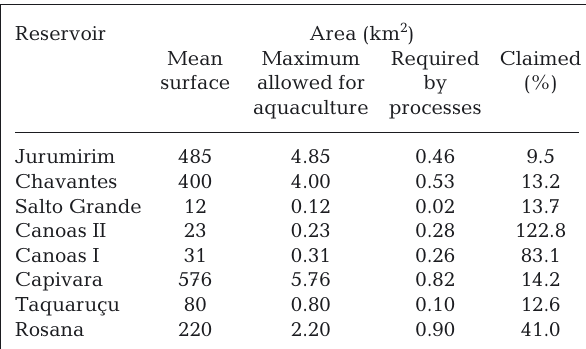
Table 4. Areas requested for the establishment of aquaculture parks in the Paranapanema River artificial reservoirs accord- ing to processes filed with the Ministry of Fishing and Aqua- culture (Ministério da Pesca e Aquicultura) between March 2004 and May 2014. The maximum area allowed for aquacul- ture and the area required by the processes were established by the government of Brazil (Brazil 2005a,